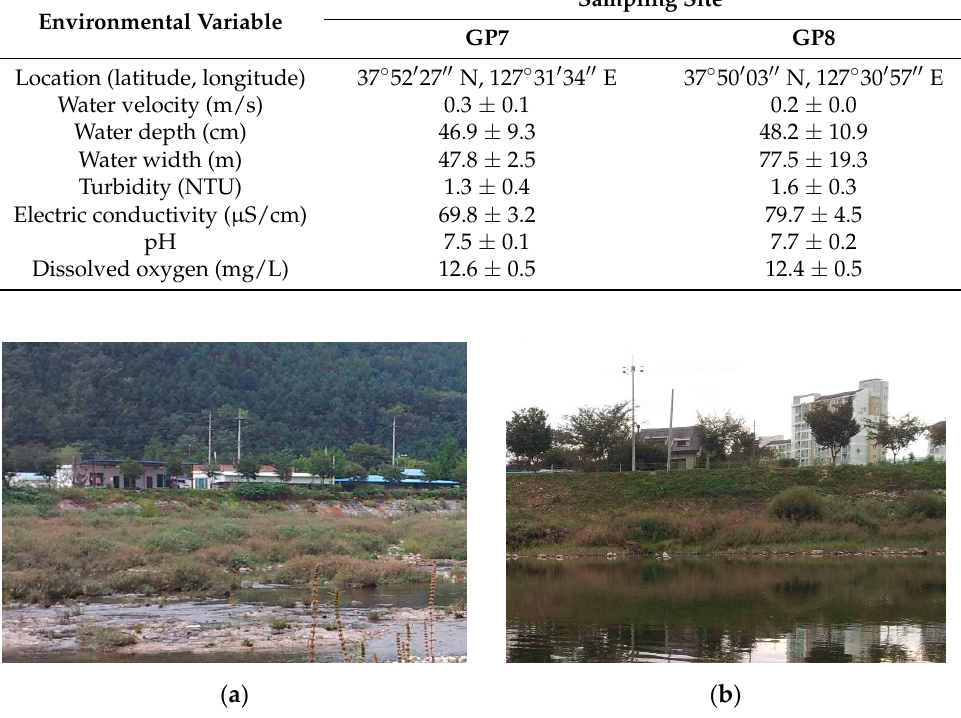
Figure 1. Photographs of sampling sites: GP7 ( a ) and GP8 ( b ).